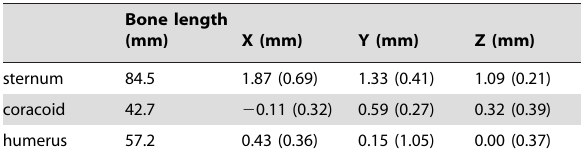
Table 4. Validation residuals at distal points comparing rotoscoped bones to marker driven